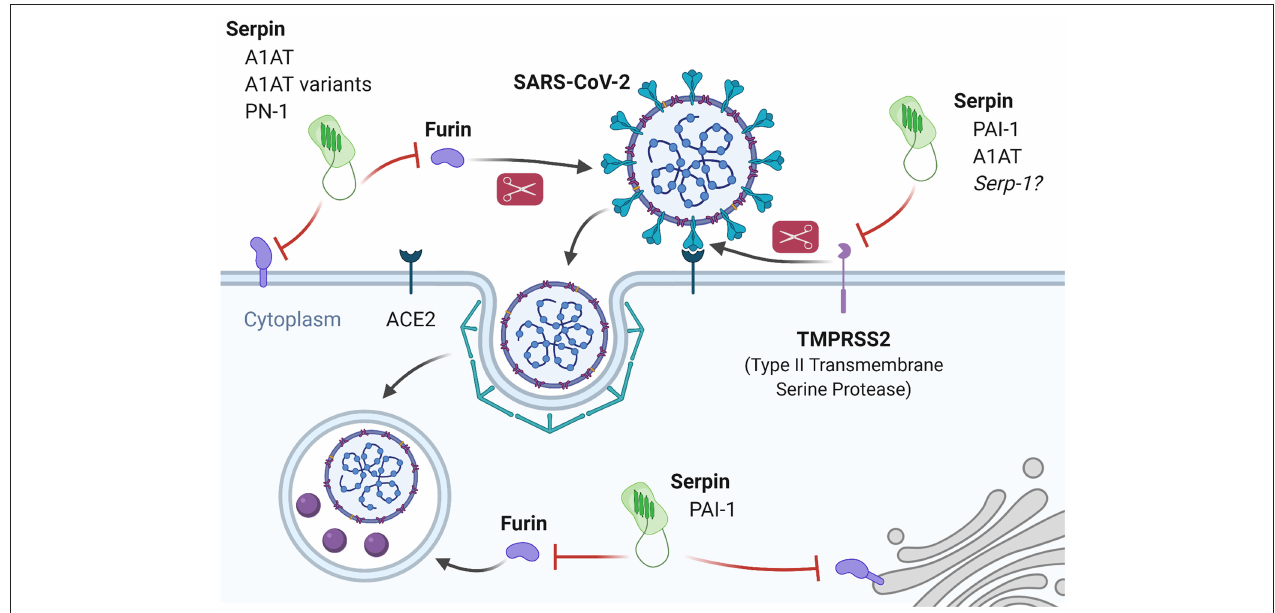
FIGURE 4 | Inhibition of SARS-CoV-2 infection and processing by fibrinolysis pathway-associated serpins. SARS-CoV-2 entry is dependent on proteolytic processing of the spike protein in order to engage the ACE2 receptor and internalize. Processing of the spike protein is performed primarily by TMPRSS2 and Furin. PAI-1 and A1AT are known inhibitors of TMPRSS2 and experimental evidence demonstrates that A1AT can inhibit SARS-CoV-2 infection in vitro . Based on similarities in inhibition properties, it may be predicted that Serp-1 will also inhibit TMPRSS2 with similar results. Furin has both an extracellular and intracellular role in the SARS-CoV-2 life cycle and there is evidence for extracellular furin inhibition by A1AT and A1AT variants (Portland and α -PDX) as well as endothelial PN-1, and for intracellular furin inhibition by